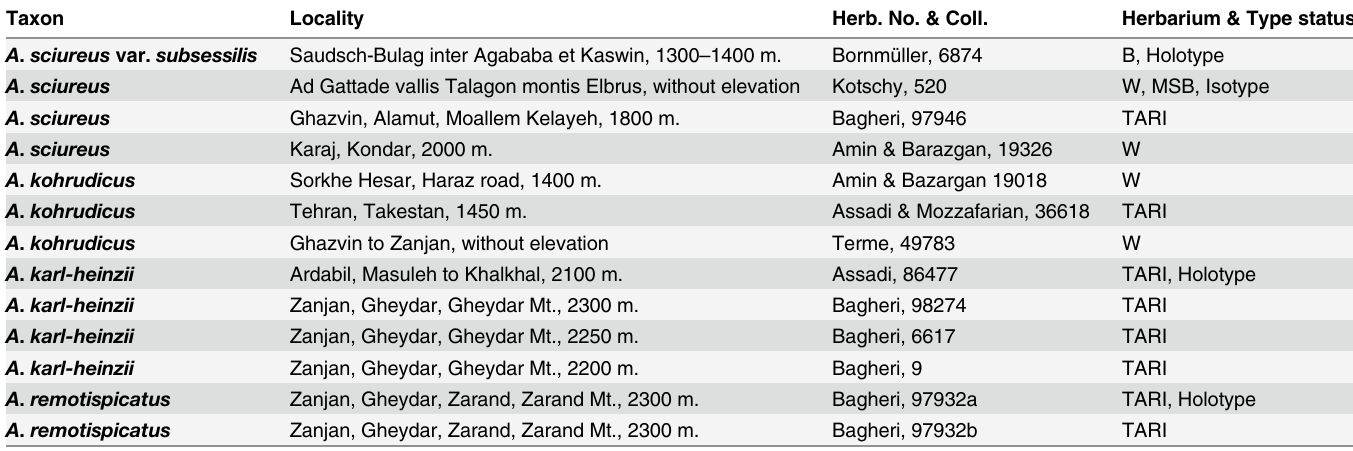
Table 1. Information of examined taxa in this